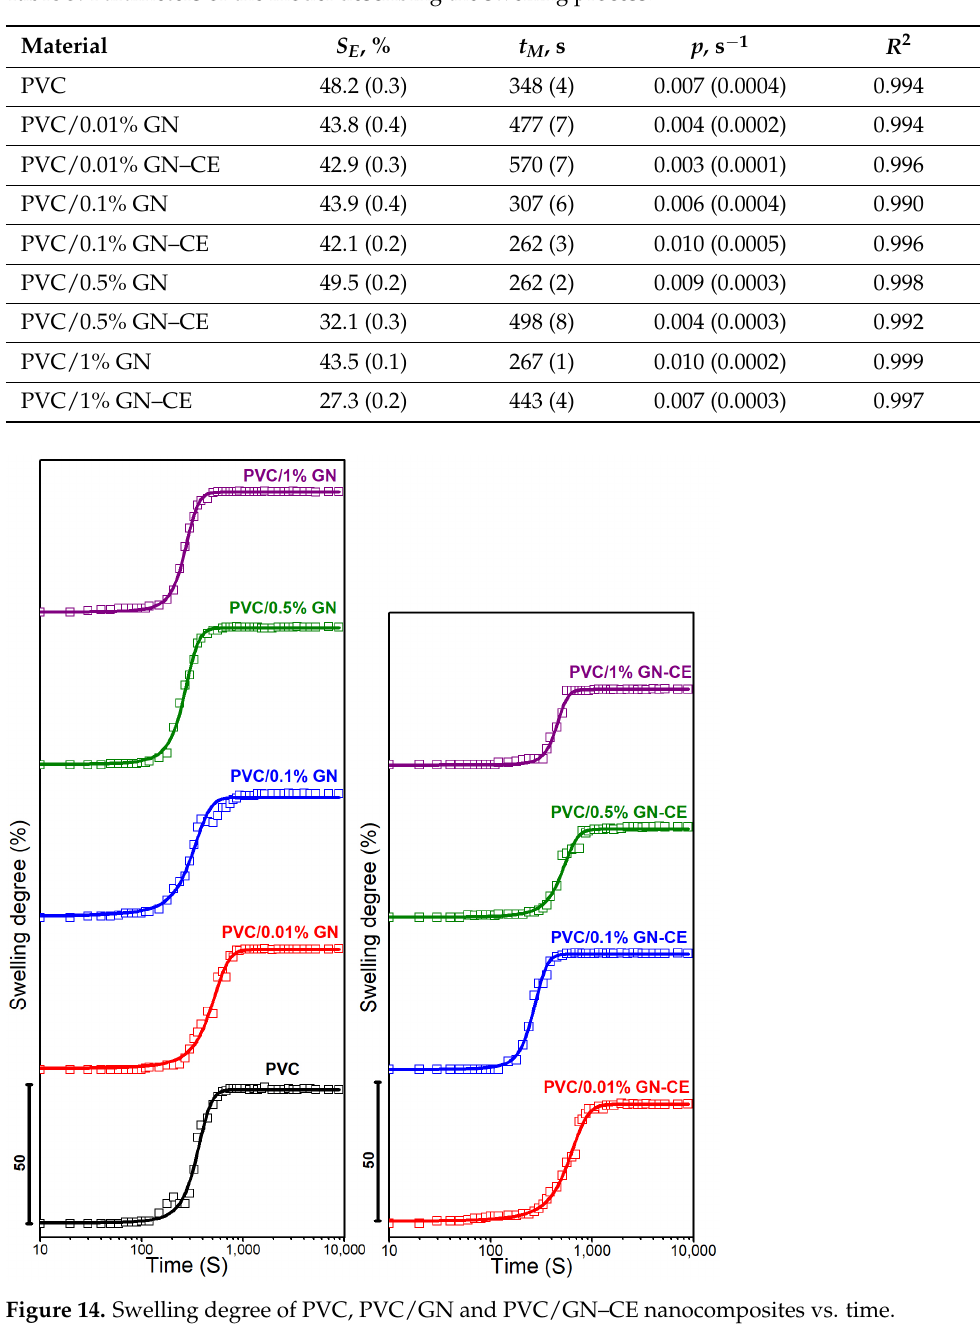
Table 3. Parameters of the model describing the swelling process.